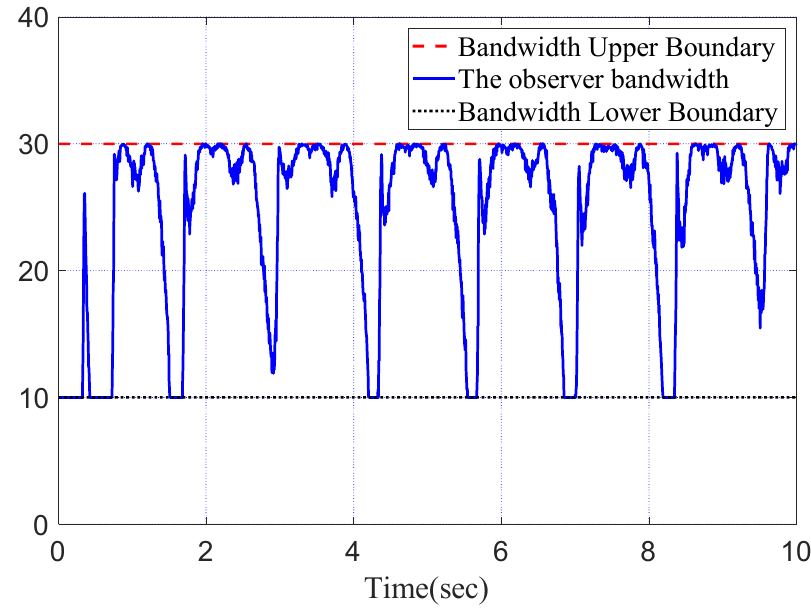
Figure 7. The observer bandwidth of ALESO. Table 2. Comparisons of SMC, GFTSMC and the proposed